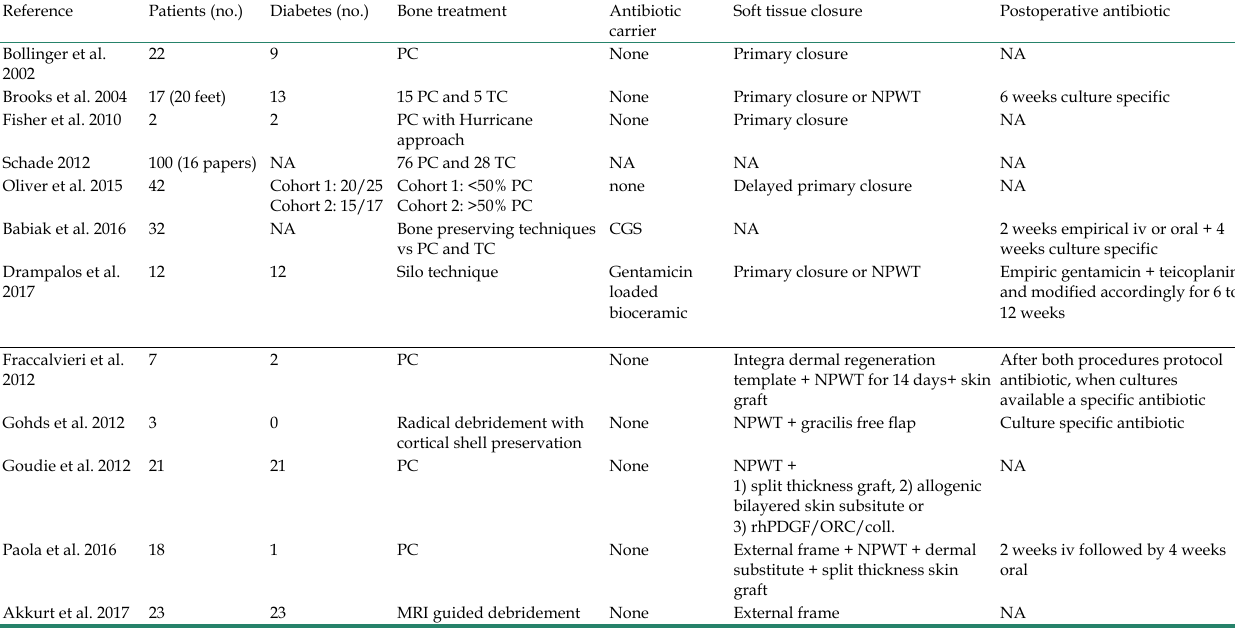
Table 1 : Systematic review of studies describing bone treatment for calcaneal osteomyelitis. Treatment Reference Patients (no.)